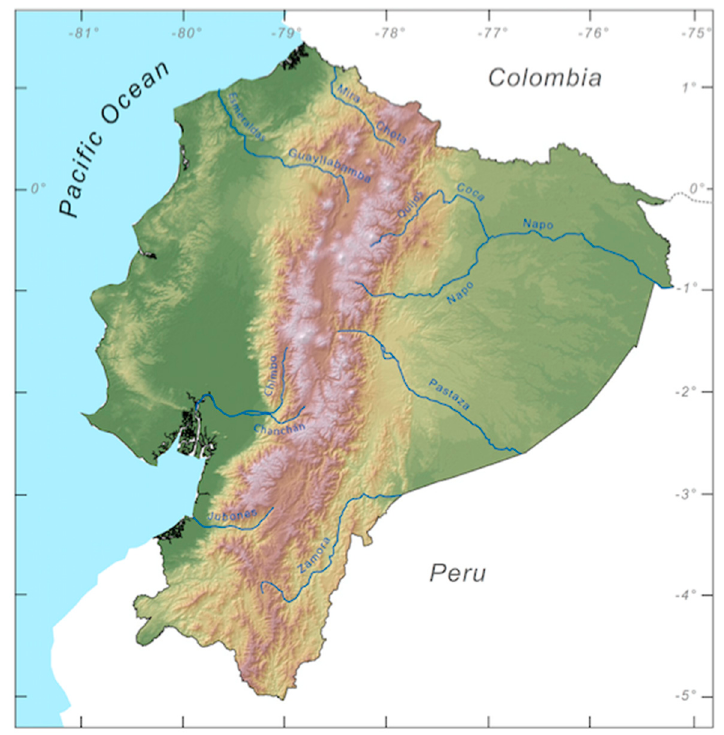
Figure 236. Potential river valleys that promote speciation in Ecuador.